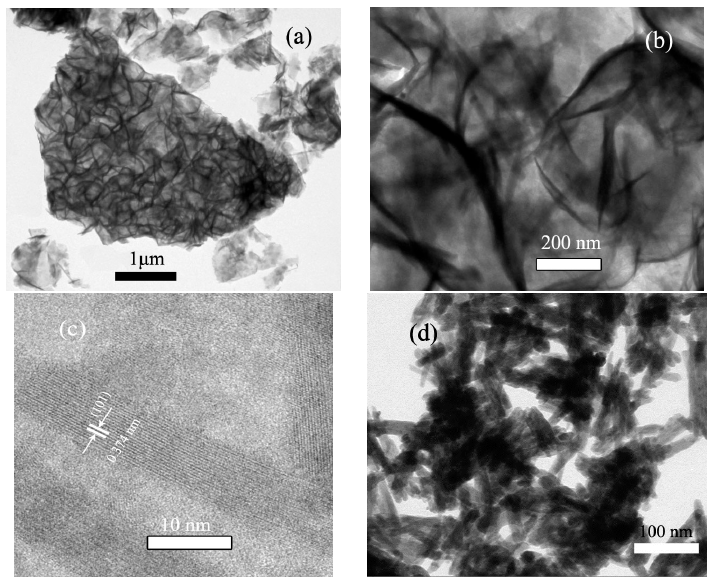
Figure 3. ( a , b ) Low-magnification and higher magnification TEM images of the BS-2# sample; ( c ) a typical HRTEM image taken from the single nanoplatelet; and ( d ) TEM image of Bi 2 S 3 nanorods.